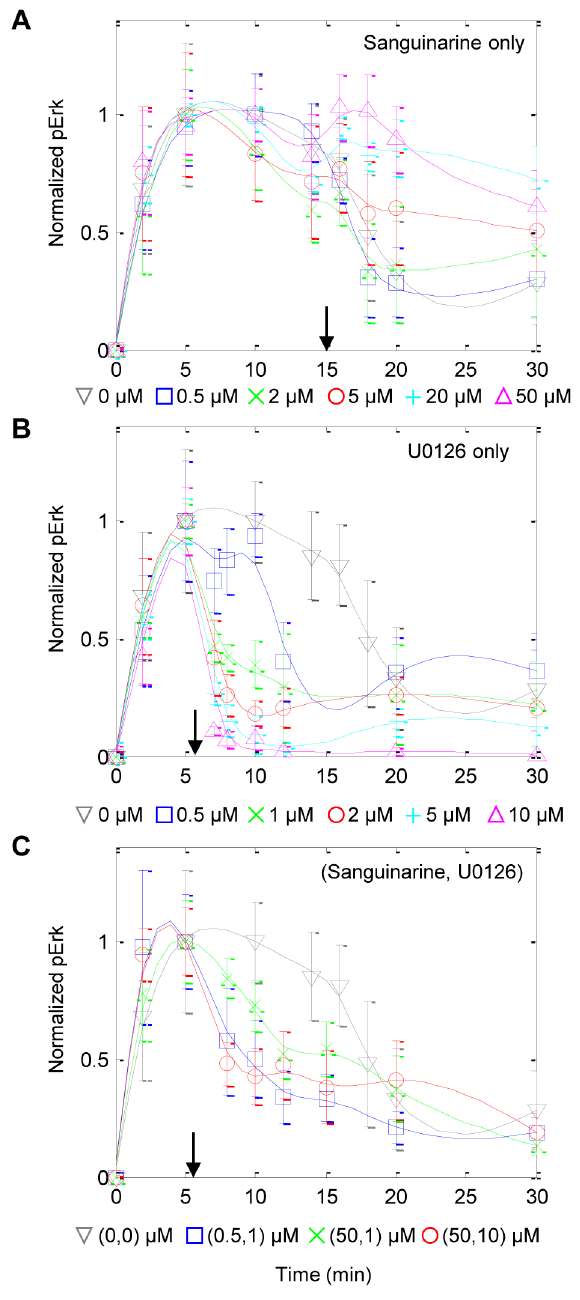
Figure 8. Training data used to generate the model weight maps. Rows correspond to doses of sanguinarine only, U0126 only, and combinations of the two reagents, respectively. Symbols and error bars denote means 6 standard errors of the raw normalized data. Lines represent smoothed data. Arrows denote the time at which the reagents were